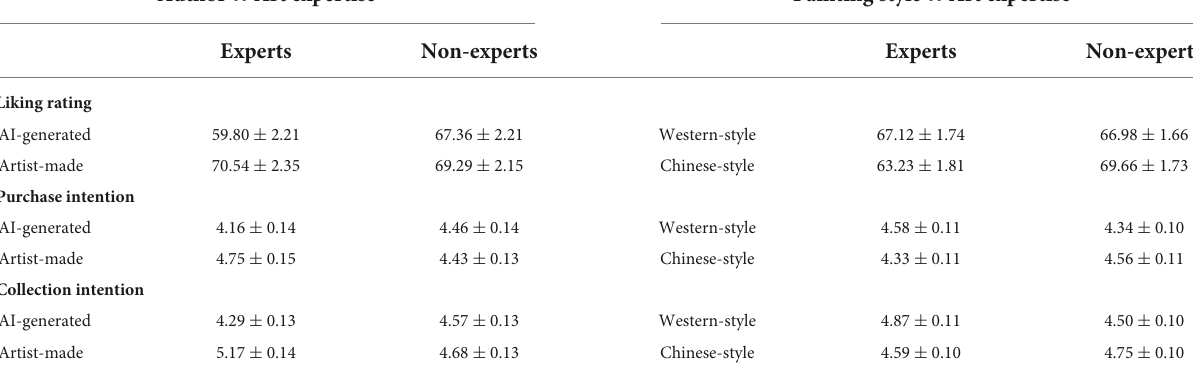
TABLE 2 Mean values of liking ratings, purchase intention, and collection intention toward